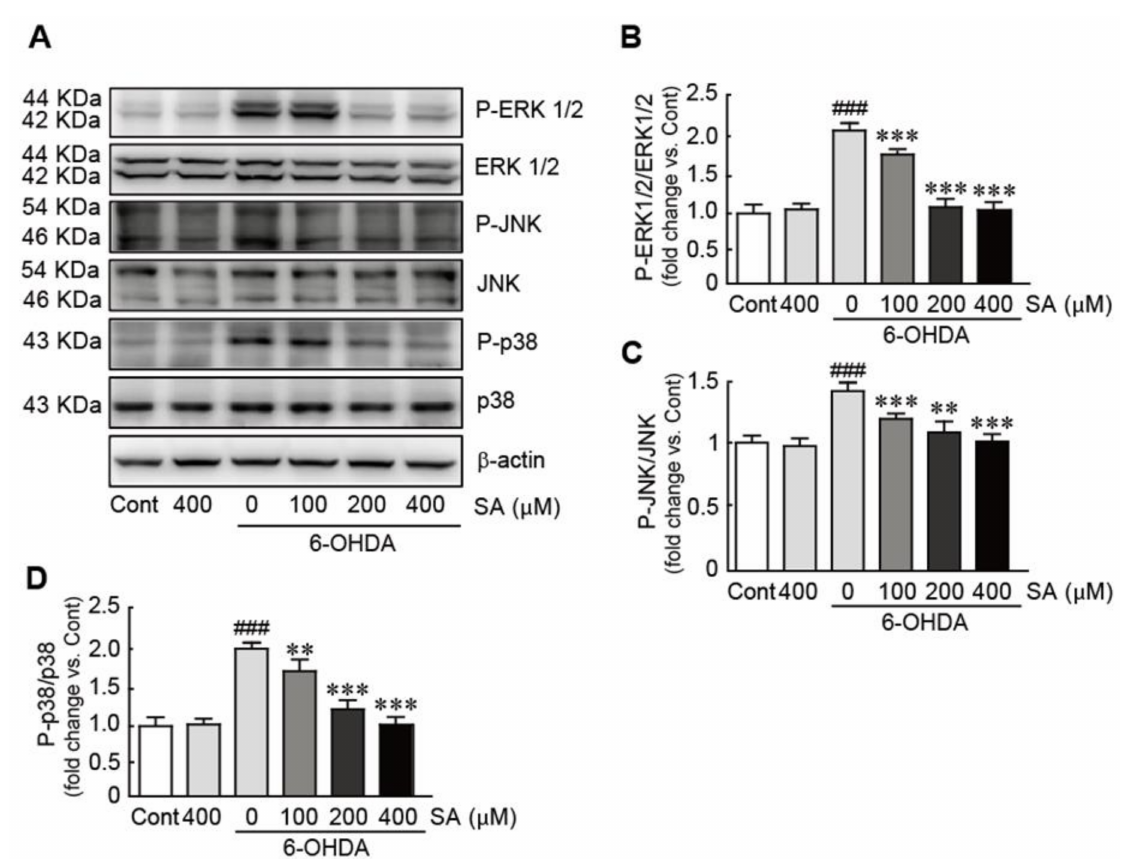
Figure 7. SA inhibits the activation of the MAPK signaling pathway caused by 6-OHDA-induced neurotoxicity in SH-SY5Y neuroblastoma cells. ( A ) Western blot analysis was performed to measure the expression levels of MAPK proteins in SA-pretreated/6-OHDA-treated cells. The expression levels of total and phospho-ERK 1/2 ( B ), total and phospho-JNK ( C ), and total and phospho-p38 ( D ) proteins were quantified using HD imaging software. β -actin was used as the loading control. Western blot analyses were performed in triplicate with three independent samples. All data were reported as the mean ± standard error of the mean (SEM). Significance was determined via one-way ANOVA coupled with Bonferroni’s post hoc test. ### p < 0.001 vs. control group. ** p < 0.01 and *** p < 0.001 vs. the 6-OHDA-only-treated group. Cont, control; SA, sinapic acid; 6-OHDA,